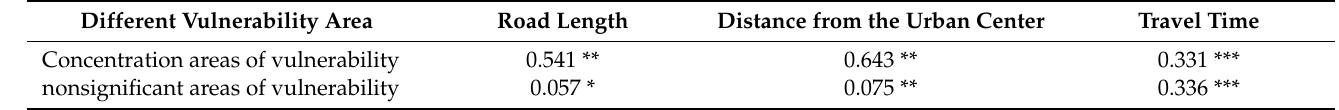
Table 5. Correlation coefficients between different factors and road